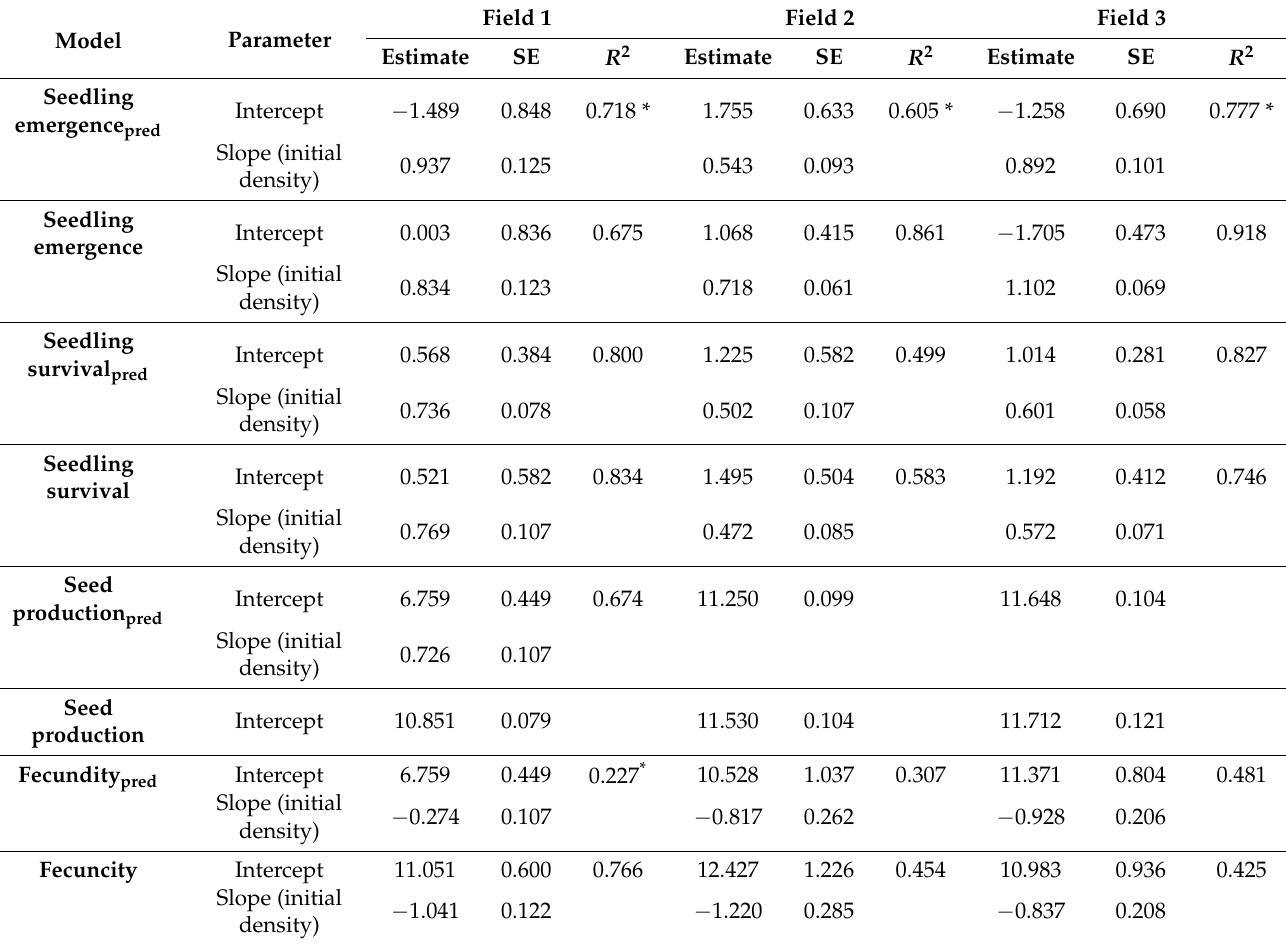
Table 1. Log-transformed parameter estimates, standard errors (SE), and R 2 values for linear regression models